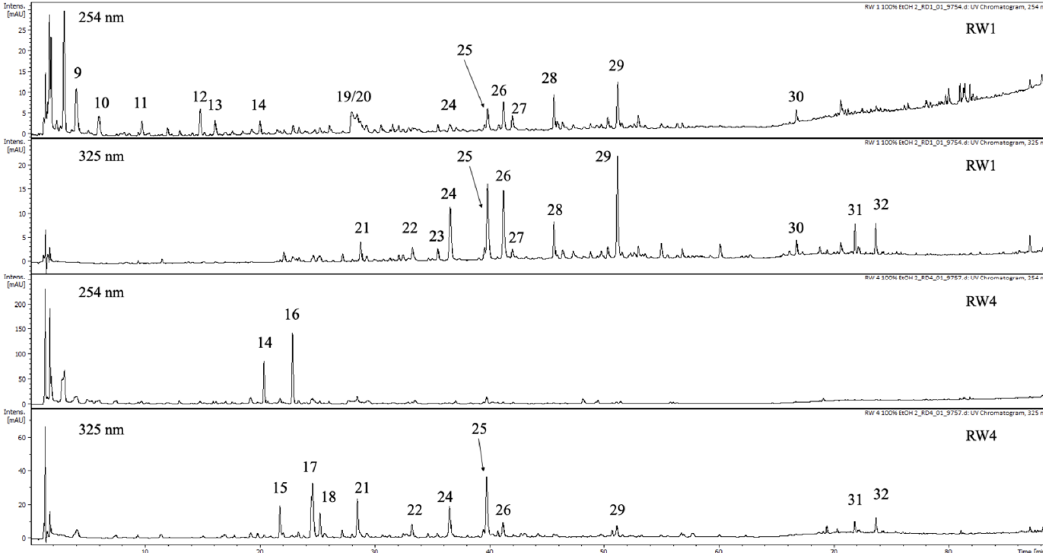
Figure 3. UHPLC-DAD-ESI-MS chromatogram of N. officinale extract from bioreactors cultures and the herb of the parent plant separation of the phenolic compounds (at 254 and 325 nm). For compound numbers, refer to Table 3. RW1 —extract of N. officinale herb, RW4 —extract of N. officinale bioreactors microshoot cultures. Table 3. Phenolic profile and contents of detected compounds in N. officinale extracts from bioreactor microshoots cultures and from the herb of the parent plant confirmed by UHPLC-DAD-ESI-MS and HPLC-DAD.